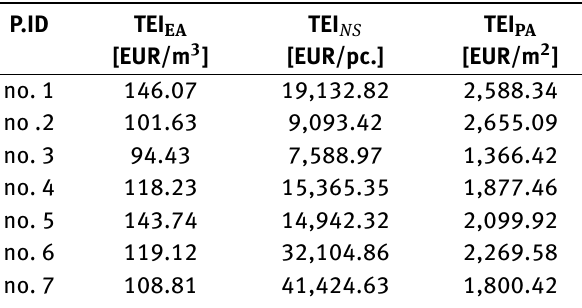
Table 5: Determination of TEI values for the individual projects.